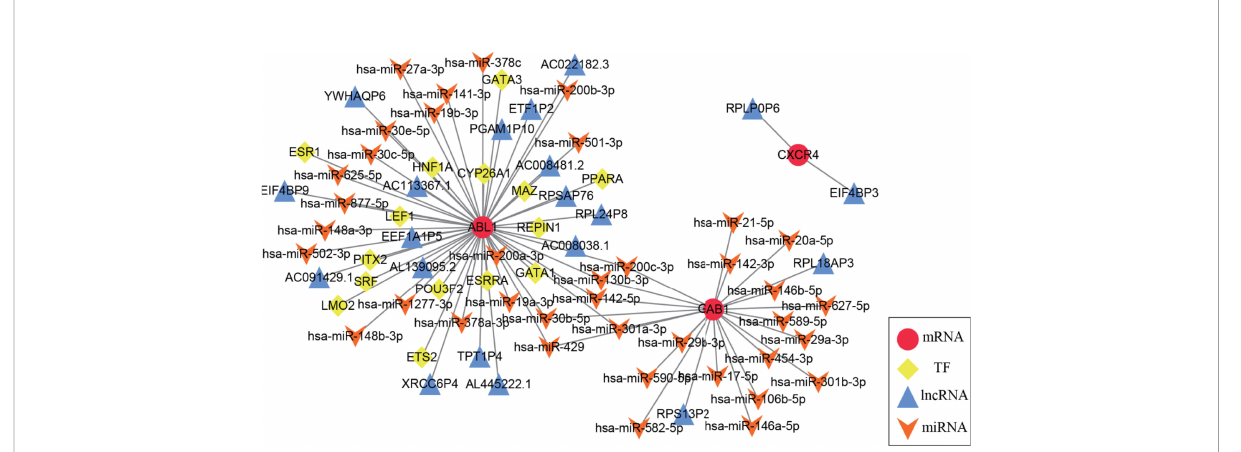
FIGURE 7 The medulloblastoma multifactor regulatory network is based on immune hub genes. In the multifactor regulatory network of immune hub genes ABL1, GAB1, and CXCR4 in medulloblastoma, each node represents a gene; red circles represent mRNA, yellow diamonds represent TF, blue triangles represent lncRNA, and orange arrows represent